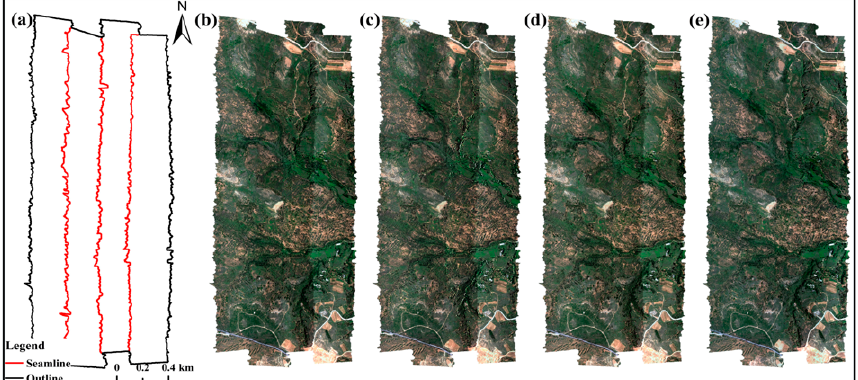
Figure 6. True color composite images before and after correction. ( a ) Outline and seamline of the hyperspectral mosaic image, ( b ) Uncorrected mosaic, ( c ) SCS+C corrected mosaic, ( d ) Minnaert+SCS corrected mosaic, ( e ) RA-TOC-CA corrected mosaic.